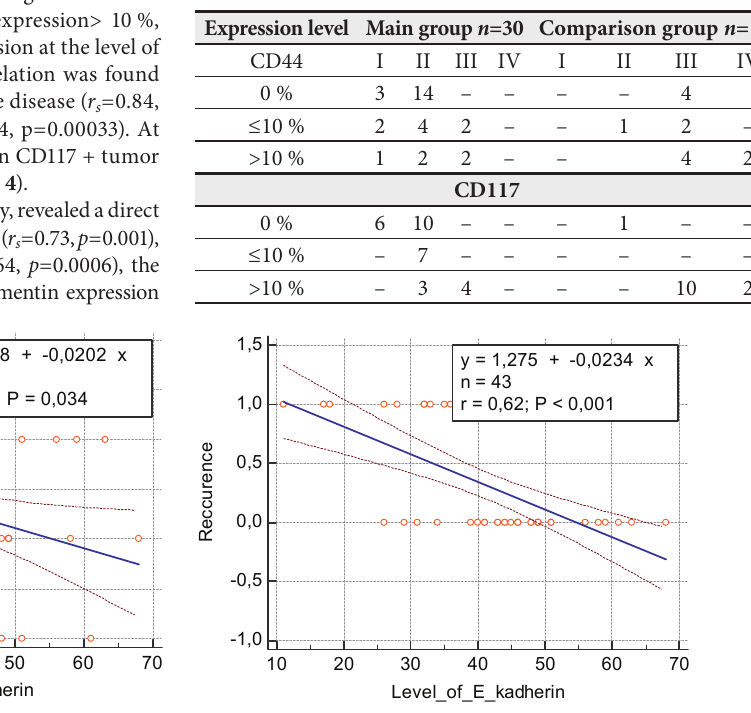
Fig. 2. Graphic representation of the relationship between E-cadherin expression and disease stage (left) and relapse (right)